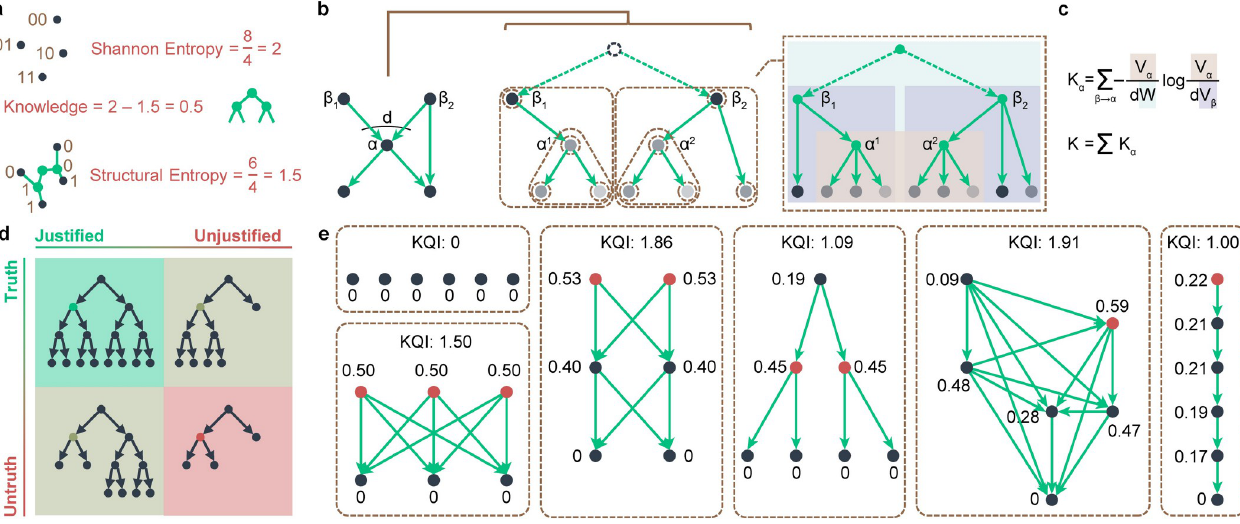
Fig 1. Quantifying knowledge with KQI. a, Three information-related quantitative indicators. Shannon entropy encodes a discrete probability distribution, where it takes an average of 2 bits to uniquely identify an object. Structural entropy takes structure into account as opposed to Shannon entropy, and it takes an average of 1.5 bits because of the shared encoding caused by the structure. The difference between these two entropies is precisely the difference caused by structure, namely the KQI. b, Knowledge tree, decomposing process, and transformation to partitioning tree. Multiple trees can be split from a knowledge tree, with volume assigned (color depth of the node). The nodes that break up eventually become fragments with less weight. Trees imply the structure of layered communities (brown dotted circle), i.e., the partitioning tree (tree in the brown dotted box). The green nodes in the partitioning tree imply the community rather than the actual nodes. c, KQI formula. α in the formula corresponds to the node in b , although it later splits into two fragments, and β corresponds to the parent nodes of α . V represents the volume (number of edges) of the subtree, corresponding to the shadows in b . W is the volume of the entire graph. d, KQI-JTB matrix. For any knowledge, volume means truth, and the difference from parents tells whether it is justified. Knowledge of maximum KQI (green) should be justified truth. Knowledge with at least one of truth and justification comes next, i.e., unjustified truth or justified untruth. Unjustified untruth has little knowledge (red). e, KQI of typical topologies. Nodes with the highest KQI are marked in